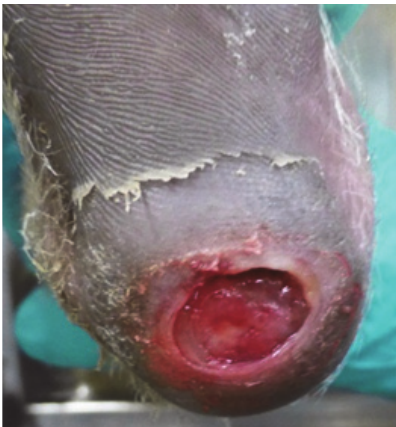
Figure 1: 2.5 × 3.5 cm lesion situated in the middle of the weight bearing part of the heel of the foot.